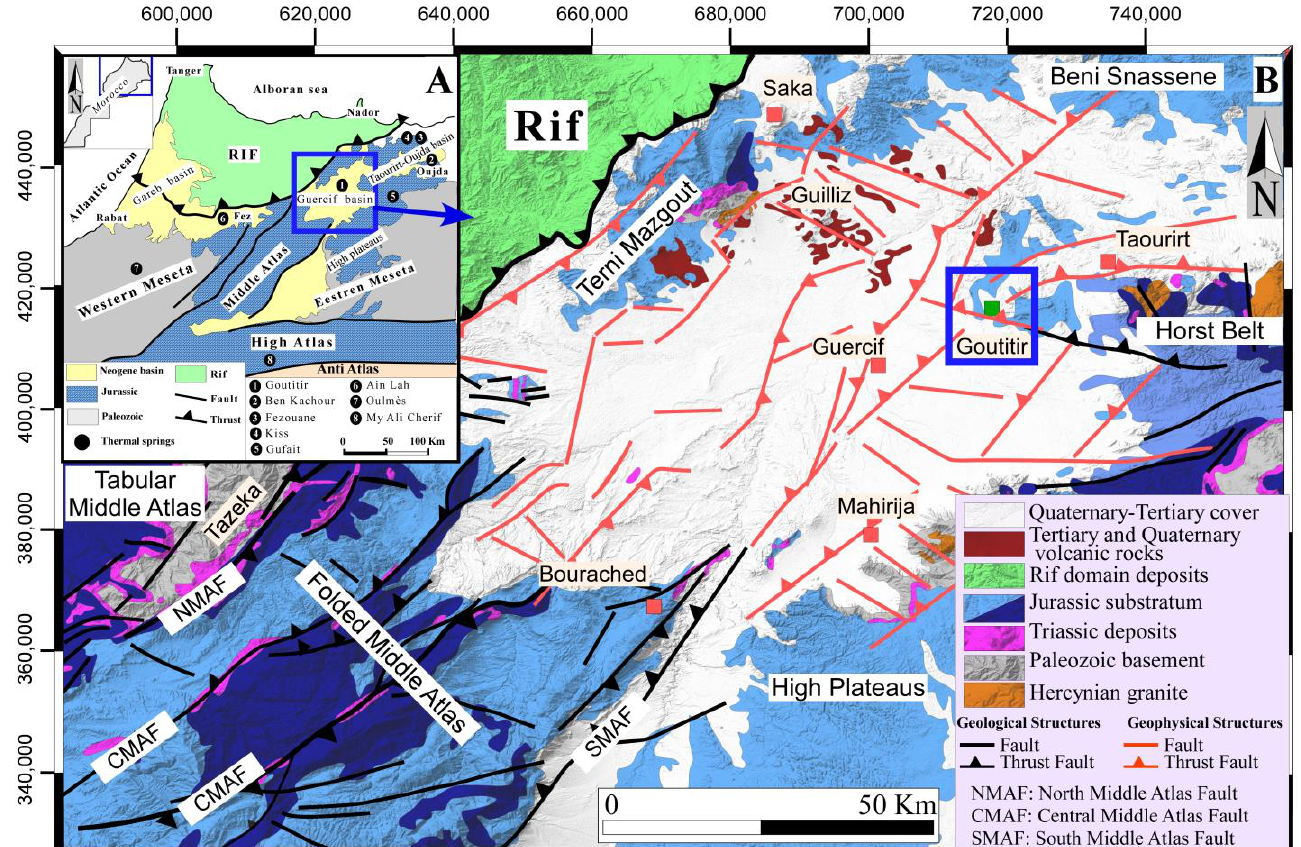
Figure 1. ( A ) Schematic geological map of northern Morocco showing the structural domains and location of a few thermal springs. ( B ) Geological map of the Guercif Basin and the neighboring region, modified from the geological map of Morocco at 1:1,000,000 scale [17].